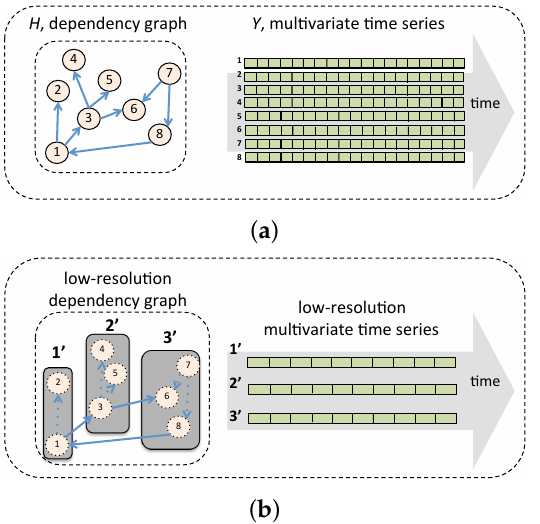
Figure 7. Increasing the temporal and variate smoothing rate reduces the details across (by taking into account the available metadata). ( a ) Original series; ( b ) Smoothed (and reduced) series. Descriptor Creation for Multi-Variate